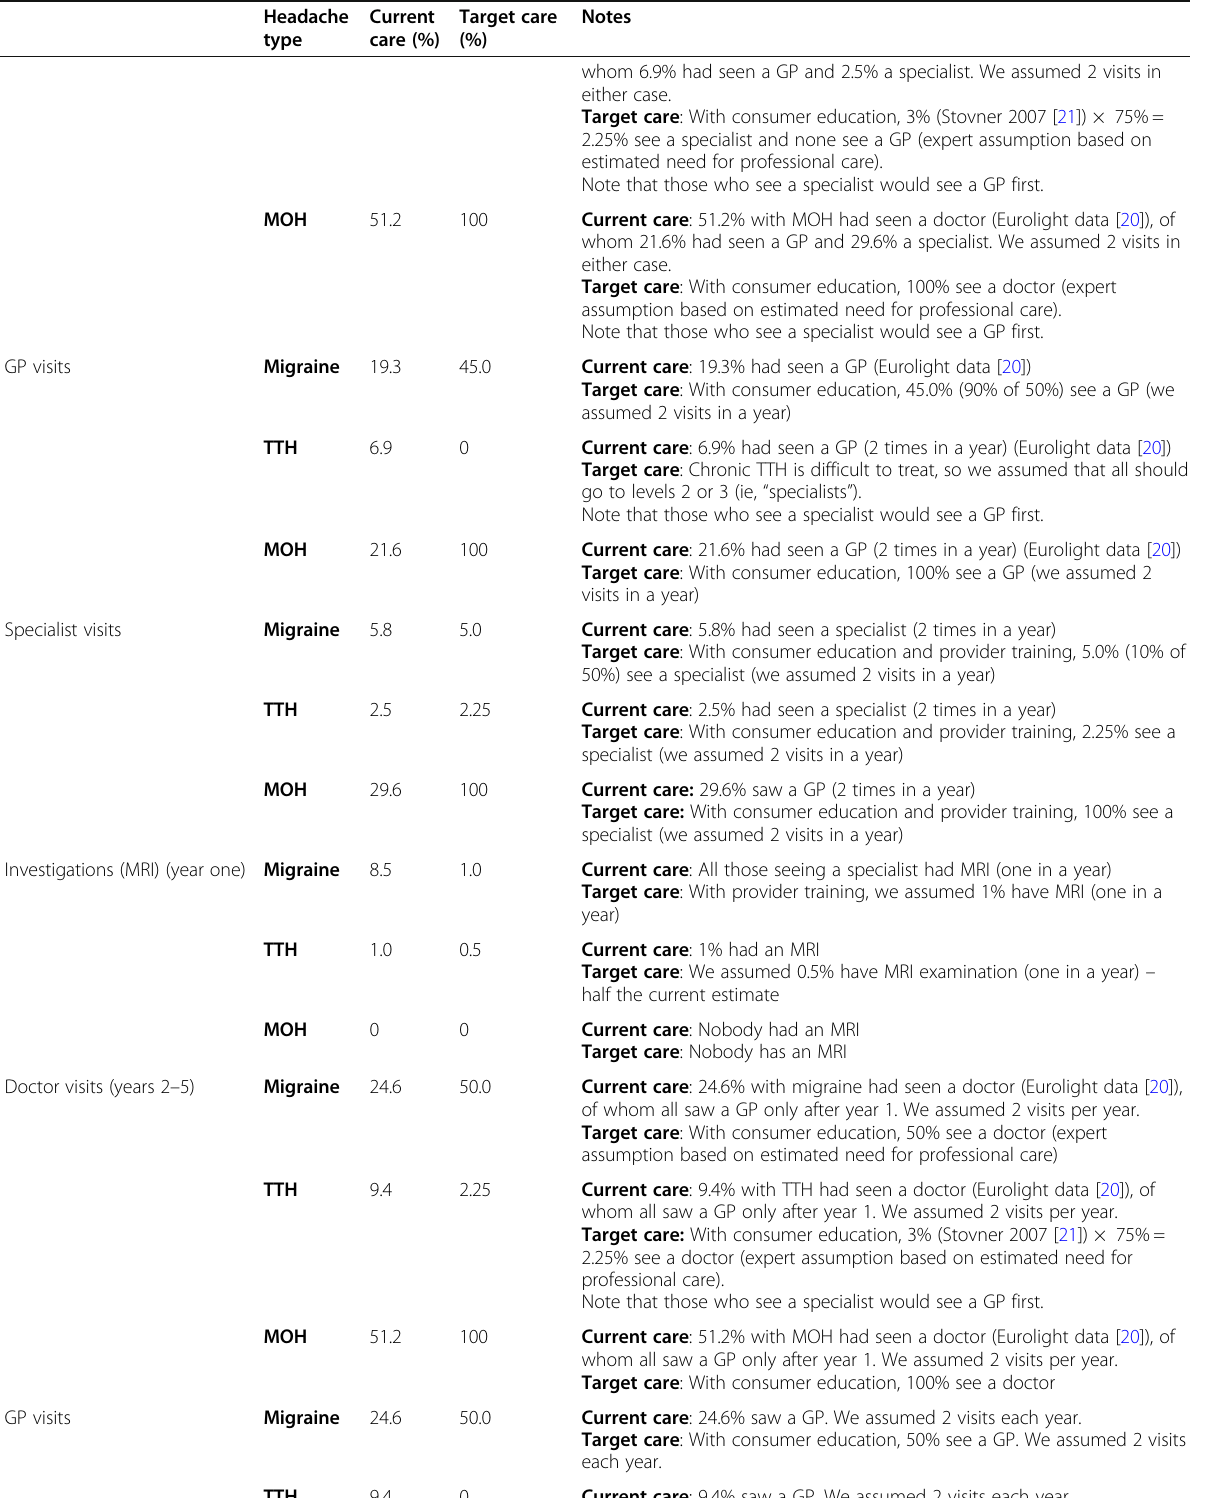
Table 2 Treatment uptake, use of resources and lost productivity according to treatment management plan (Russia)